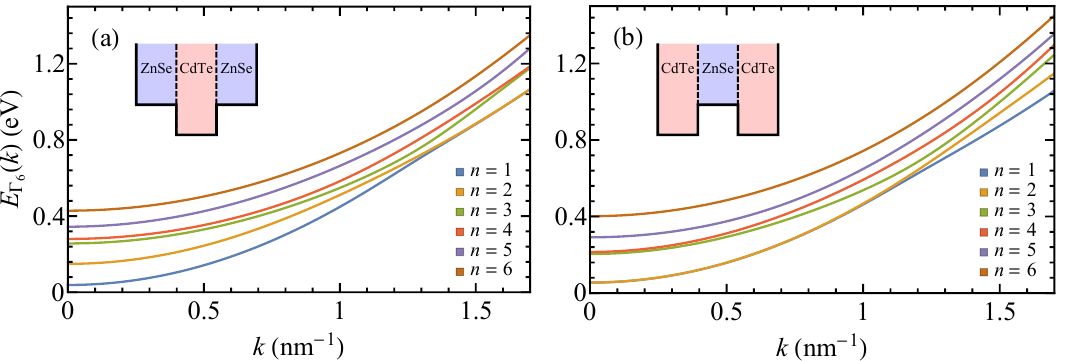
Figure 2. First six subbands of ( a ) ZnSe/CdTe/ZnSe and ( b ) CdTe/ZnSe/CdTe nanoplatelets with L core = L shell = 7 nm. The energy is measured from the bottom of the conduction band of bulk p perturbation theory gives the most accurate results in the vicinity of the Γ CdTe. Note that the k · point, where the perturbation term is much smaller than the band gap energy (1.51 eV for CdTe) [53]. The material parameters for ZnSe and CdTe were taken from reference [51].